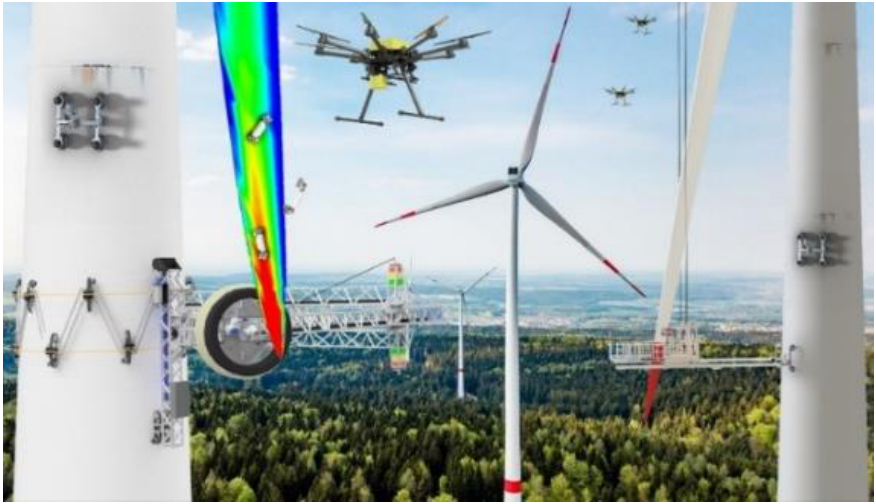
Figure 1. Wind farm maintenance vision .